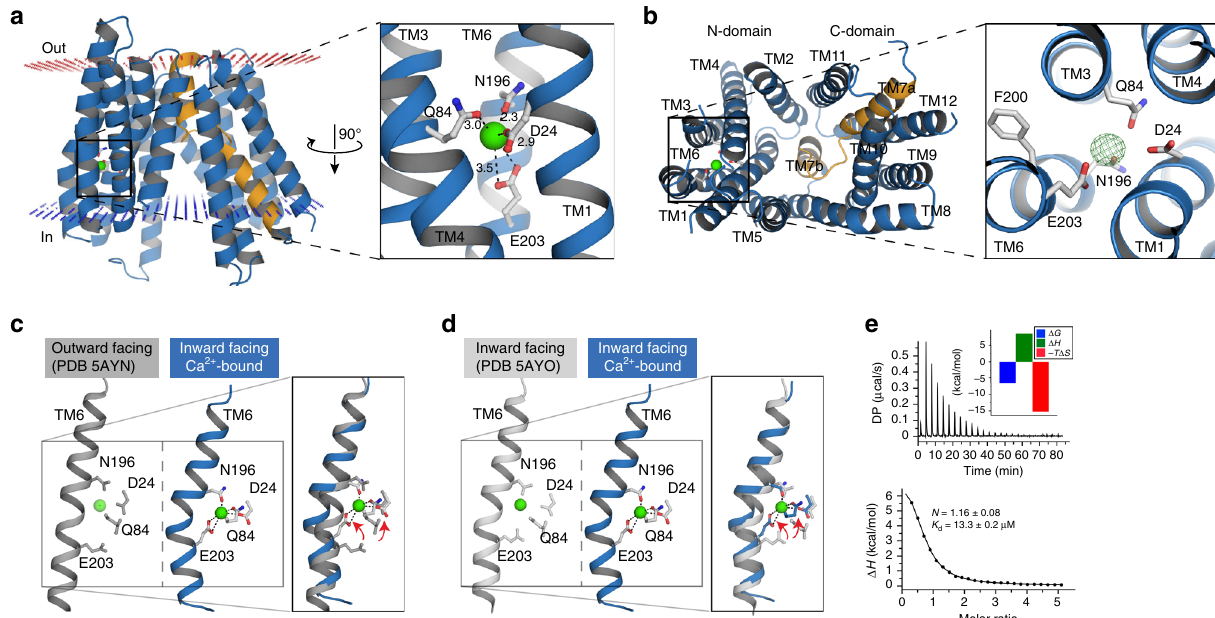
Fig. 5 Crystal structure of a Ca 2 + -bound BbFpn reveals a conserved binding site. a Overall structure of the Ca 2 + -bound inward facing conformation of BbFpn and close up view of the Ca 2 + site (right). Approximate location of the membrane bilayer is illustrated with red (outside) and blue (inside) dots, generated using the PPM server 41 . TM7 is highlighted in orange. The Ca 2 + ion is colored in green, and coordinating residues are shown in ball-and-stick. Some of the distances are longer than the reported ideal Ca 2 + – O distance (~2.5 Å) 42 , although this is not unprecedented considering the resolution of the structure 17 . b Intracellular view (left) and F o – F c omit map of the Ca site (right; contoured at 5.5 σ ). c , d Binding of the Ca 2 + ion leads to a kink forming in TM6, likely promoted by the Ca 2 + coordinating N196 and E203. e Representative ITC experiment between wild type BbFpn/Ca 2 + . Stoichiometry ( N ) and dissociation constant ( K d ) of each interaction are indicated. The variations in free energy ( Δ G ), enthalpy ( Δ H ), and entropy ( − T Δ S ) are respectively, in blue, green, and red in the = 46 ± 3.3 μ M; Supplementary Fig. 5d), in agree- for Ca 2 + ( K Sr d